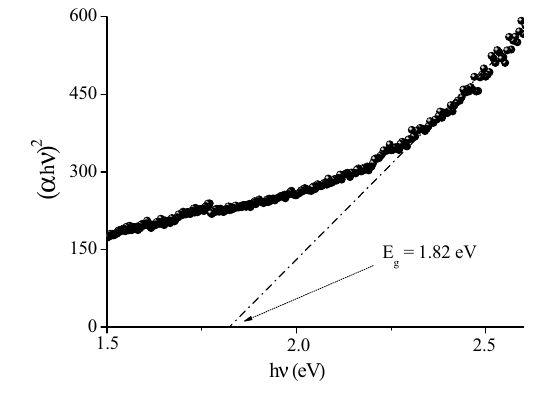
Fig. 4 The variation of ( αhν ) 2 versus hν